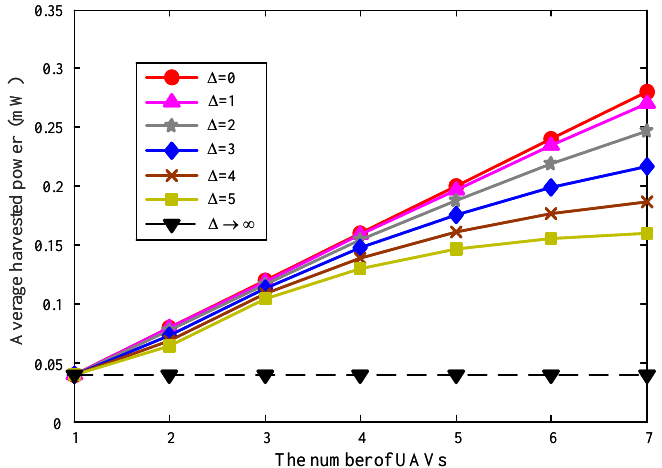
Figure 7. The average received power versus the number of UAVs M